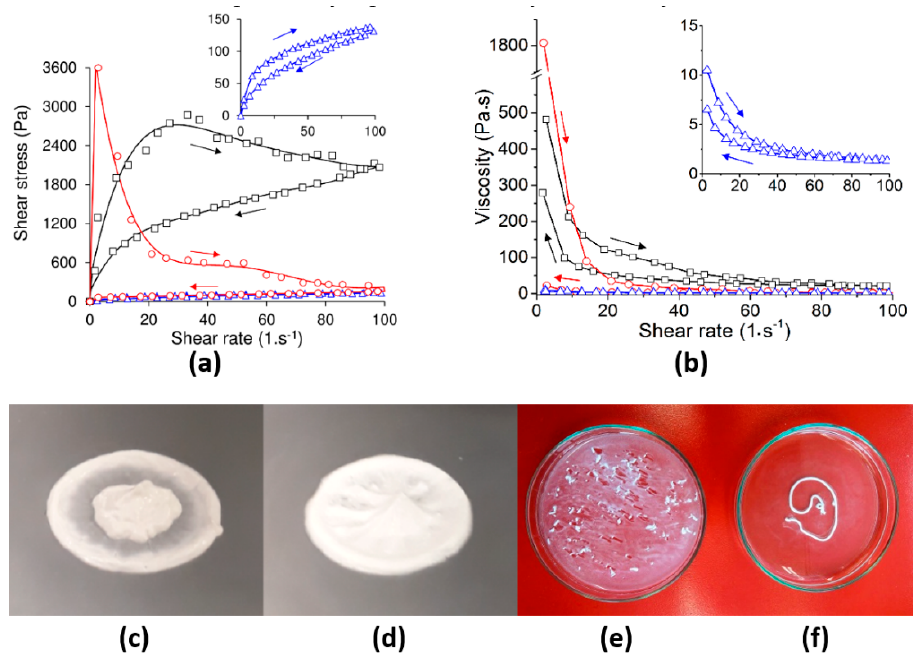
Figure 3. Steady rheological analysis and the viscosity curves of the copolymer solution and CPCs after 1 min of setting. Relationship between shear stress and the shear rate ( a ) and relationship between viscosity and the shear rate ( b ) of the 20 w / v % copolymer solution (blue line with triangles), α -TCP paste with deionized water (red line with circles) and α -TCP paste with 20 w / v % copolymer solution (black line with squares), prepared at an L/P of 0.5 g · g − 1 at 25 ◦ C. The arrows indicate the outward and return sweeps; the hysteresis loop indicates thixotropy. While the α -TCP cement made from the addition of pure water separated following steady state rheological measurement ( c ) and disintegrated following immediate injection in water at 37 ◦ C ( e ), the α -TCP cement made from the addition of the 20 w / v % copolymer solution remained homogeneous ( d ) and exhibited cohesion following injection in water at 37 ◦ C, retaining the shape of the injected filament ( f ).